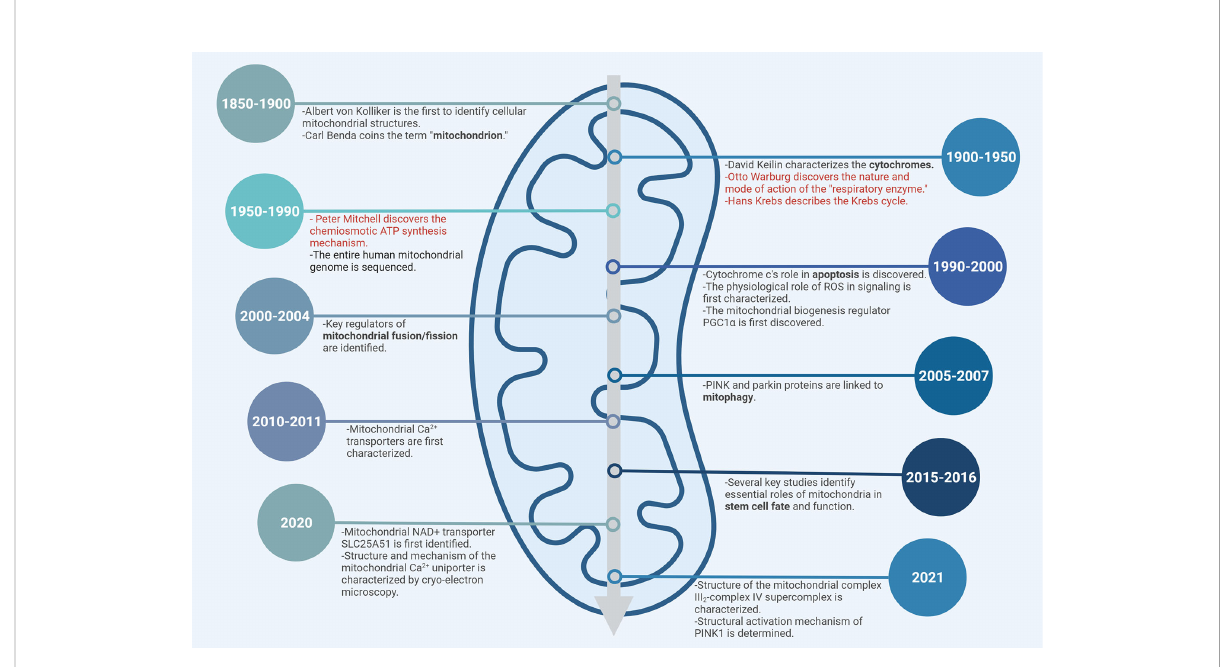
FIGURE 3 Timeline of mitochondrial biology. Subset of major milestones and discoveries are shown. Nobel Prize-winning discoveries are highlighted in